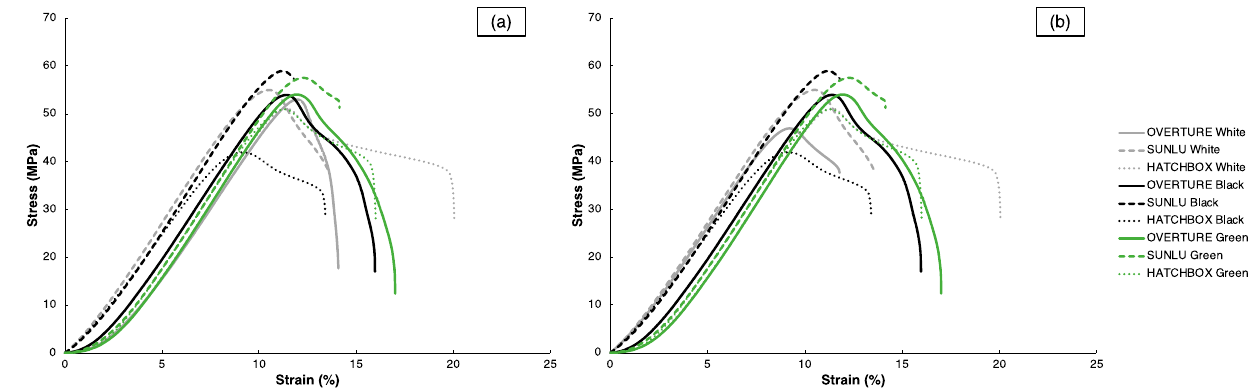
Figure 4. Engineering tensile stress–strain curves for representative Phase 1 samples for each filament that express ( a ) the best mechanical properties and ( b ) the optimal parameter sets.